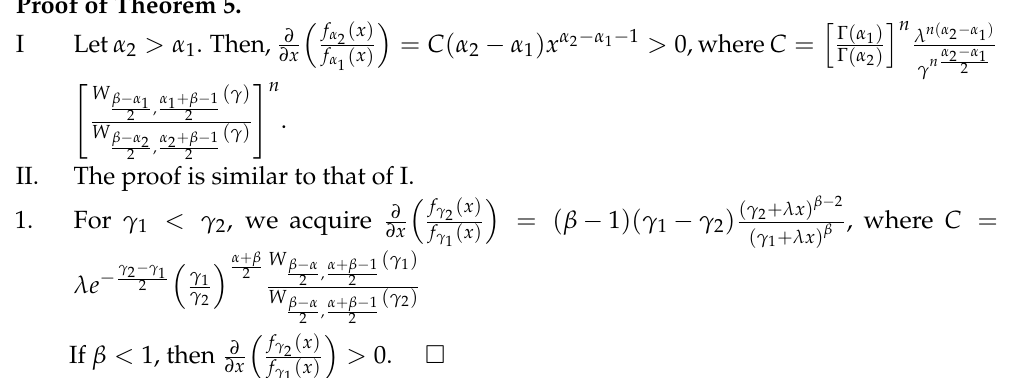
Figure 2. The relation between 𝛼 and 𝛽 , and the concavity of 𝑊𝐷(𝛼, 𝛽, 𝛾, 𝜆) . Example: The second derivative of the log of density is, 𝜕 (cid:2870) 𝑔(𝑥) =